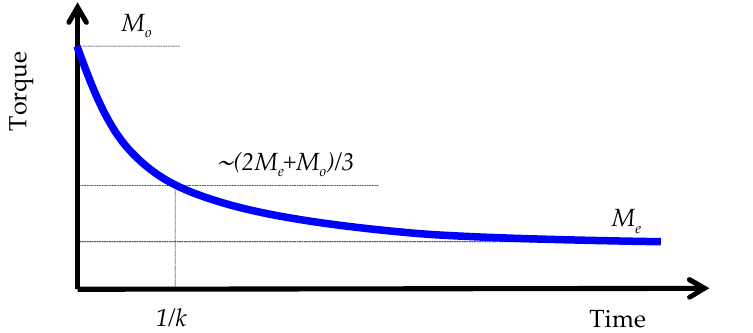
Figure 2. Schematic plot of the evolution with time of the torque after a step-up in angular velocity according with Tattersall [1]